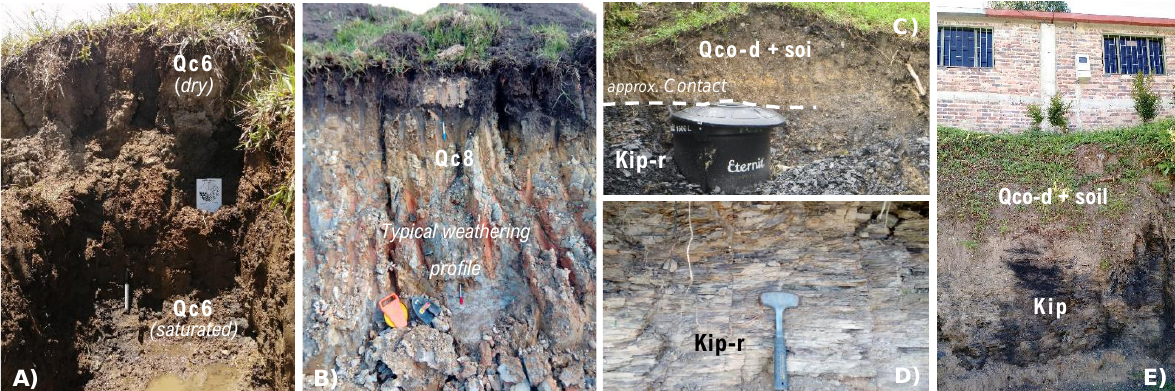
Figure 7. Field occurrence of the materials (surface formations) covering the rocks. ( A ) Unstable sandy – muddy colluvium in a paddock uphill from America India neighborhood, in whose trench a sample was taken for soil micromorphology. ( B ) Another colluvium of silt – clay matrix, typically variegated by the presence of oxides, hydroxides, clays, tectosilicates, zeolites, or other crystalline and organic phases, deeper and developed on a flat morphology zone (around the La Rosita neigh- borhood, east of V é lez) and with high recharge. ( C ) Weathered mudstone (dark gray), in transitional contact with a mixture of soil and dispersed (-d) colluvial material, of brown, yellowish, and gray colors, with angular lithics, in the back garden of a Palenque house. ( D ) Outcrop in the village Las Amarillas, whose petrophysical properties have increased, being more friable and susceptible to mass movements. ( E ) A house in Ricaurte neighborhood founded on residual soil mixed with discordant colluvium on the marine rocks (masked by clear patinas of weathering). Q: Quaternary; c: colluvium; Kip-r: regolith of the Paja Fm., dated to the last period (Ki) of the Mesozoic